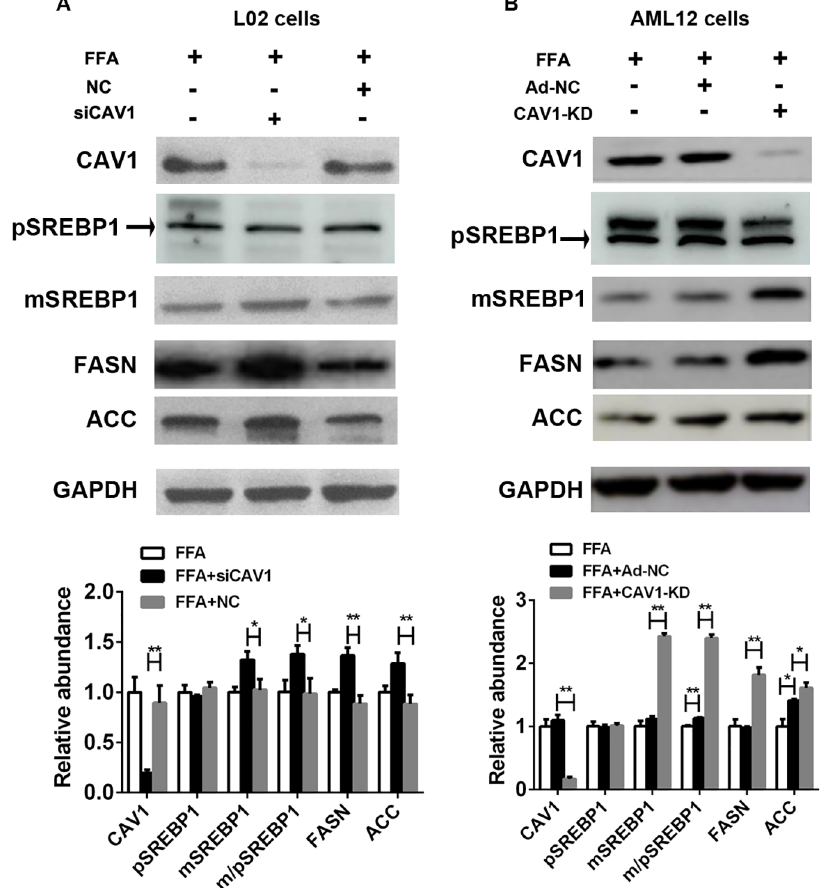
Fig 5. CAV1-knockdown upregulates the protein expression of genesinvolved in lipid metabolism in the FFA-stimulated L02cells and AML12cells. L02hepatocytes weretransfectedwithscrambledsiRNA(NC)or siRNAtargetingCAV1(siCAV1).AML12hepatocytes weretransfected withtheadenovirus-CRISPR-Cas9 systemto stablyknockdownCAV1(CAV1-KD)whileAd-NCservedasa control.Cellswerechallenged with1 mM FFA for 48 h. The proteinexpressionlevelsof fatty acidmetabolism genes,includingSREBP1,FASN andACC, weredeterminedbywesternblotandquantified withGAPDHasa loadingcontrolin FFA-treated L02cells(A) and AML12cells(B). pSREBP1andmSREBP1denotethe precursorandmatureforms of SREBP1,respectively. The resultsrepresentdatafrom 3 independent experiments.